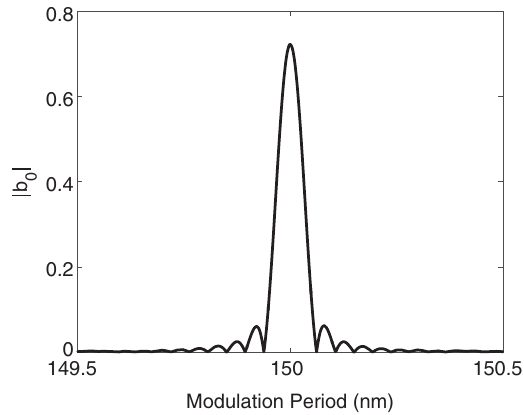
FIG. 4. The calculated b 0 with ∼ 150 nm spacing for the forward scattered (0th order) electron